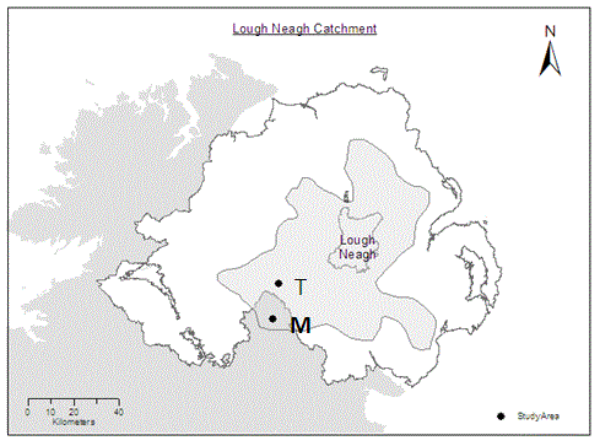
Figure 1. Map of Northern Ireland and part of the Republic of Ire- land showing the Lough Neagh catchment and location of Co. Ty- rone (T) and Co. Monaghan (M) study